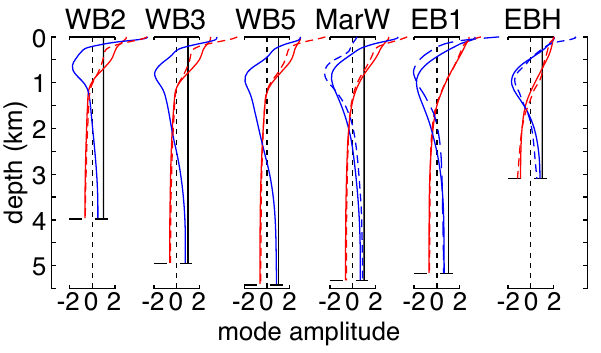
Fig. 2. Vertical mode shapes at each station, for depth-uniform modes (black), flat-bottomed baroclinic modes 1 (red solid) and 2 (blue solid), and KB baroclinic modes 1 (dashed red) and 2 (dashed blue, only calculable at stations MarWest, EB1, and EBH). The lo- cal water depth is indicated by a dashed horizontal line. The modes are normalized to unit vertical rms and are